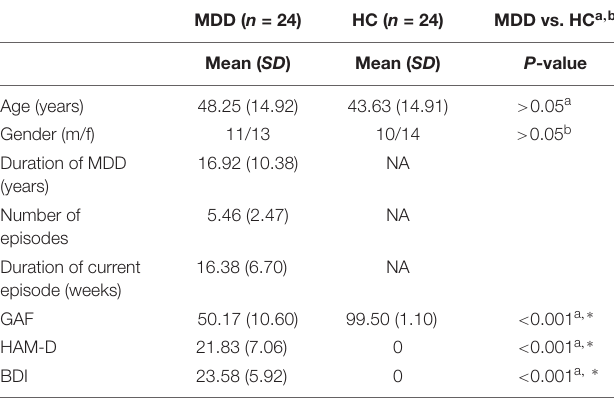
TABLE 1 | Demographic and clinical